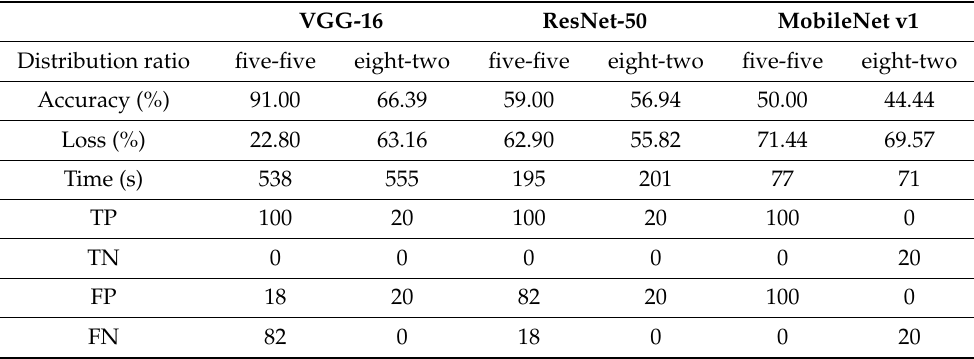
Table 5. Training results obtained ith VGG-16, ResNet-50, and MobileNet v1 with two data distributions.